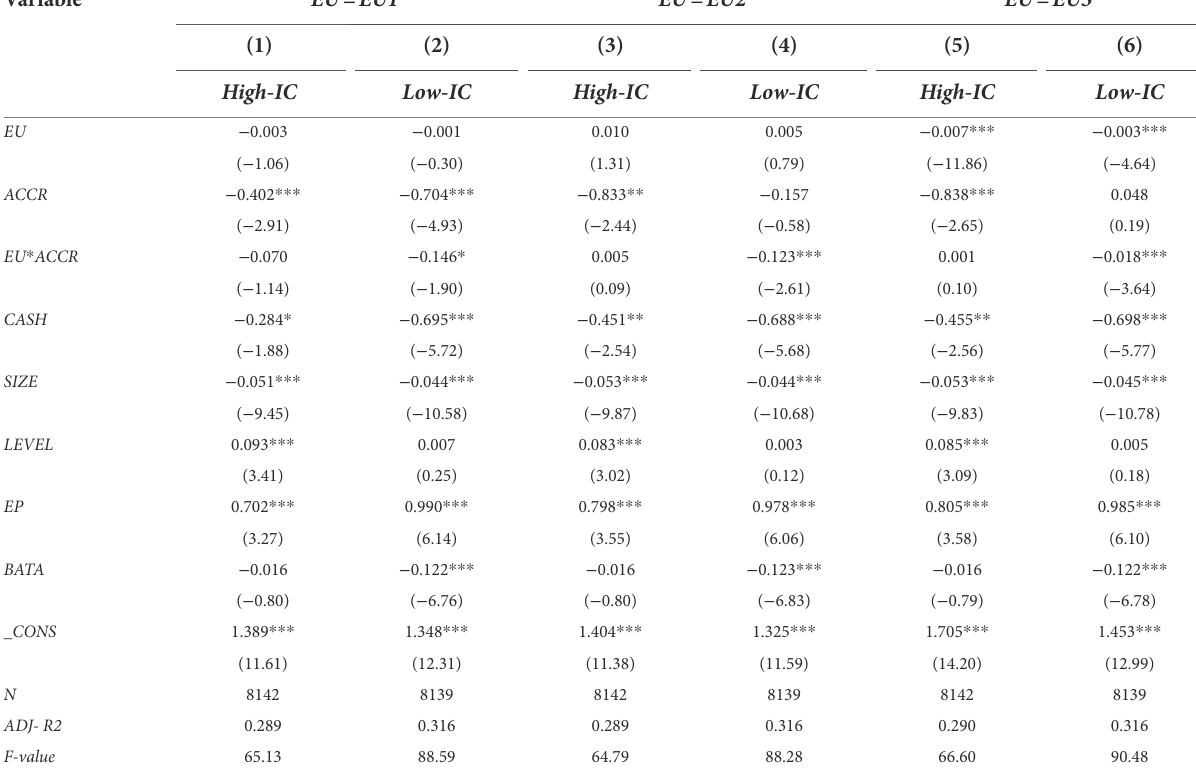
TABLE 6 The relation between environmental uncertainty and accrual anomaly in Group 2.